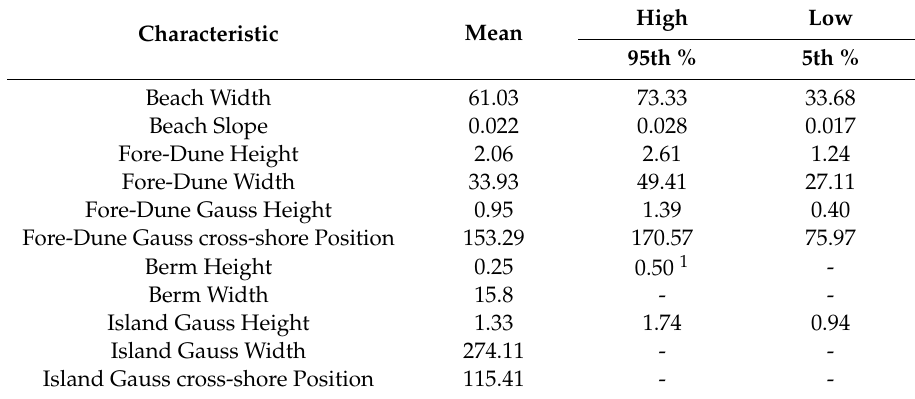
Table 1. Dauphin Island beach, dune, and island feature height and width means, highs (95th percentile), and lows (5th percentile), in meters (elevations relative to NAVD88; slope in m /